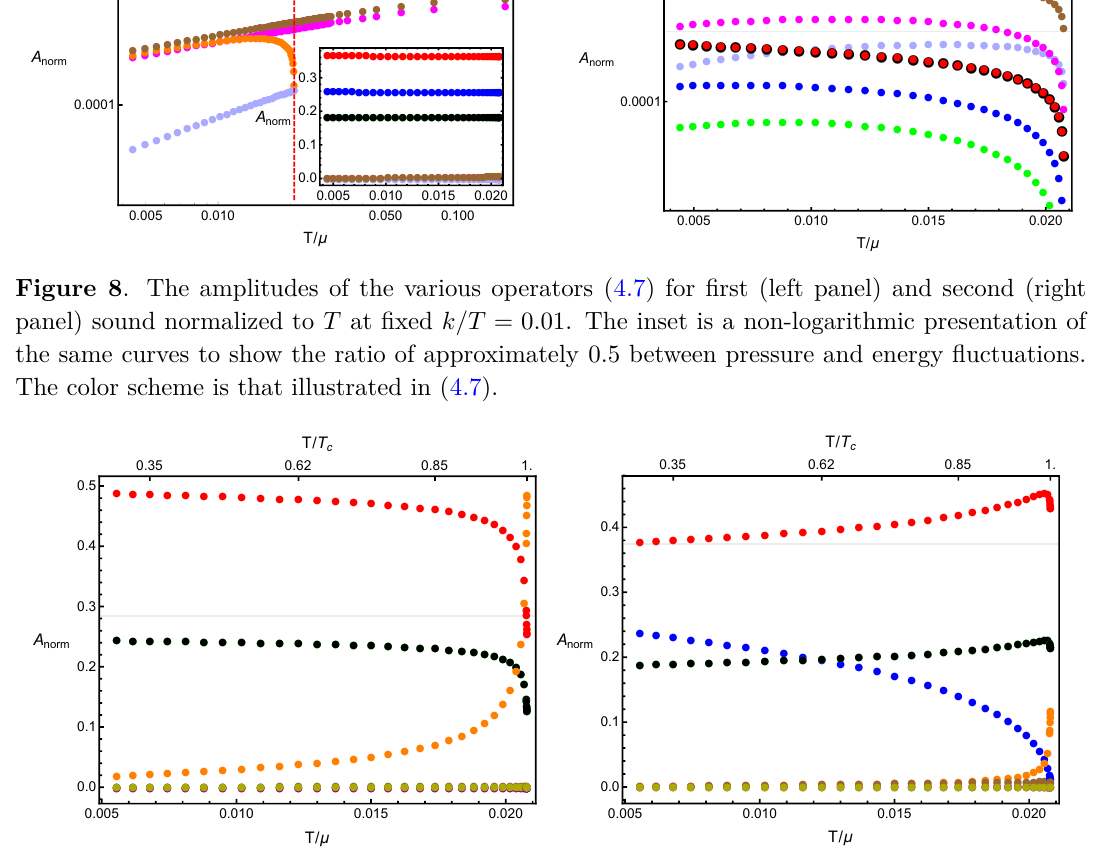
Figure 9 . The amplitudes of the various operators (4.7) for the diffusive mode ( left ) and 4 th sound ( right ) in the superfluid phase with momentum dissipation. We fixed α/T = 6 and k/T = 0 . 01 . The color scheme is that illustrated in